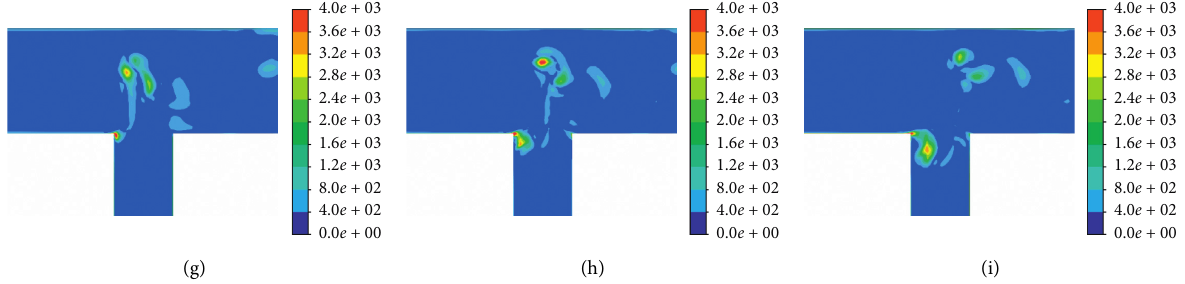
Figure 13: Vorticity ( t 3 � 1.7–1.72s unit: s − 1 ): (a) 0T/8, (b) 1T/8, (c) 2T/8, (d) 3T/8, (e) 4T/8, (f) 5T/8, (g) 6T/8, (h) 7T/8, and (i) 8T/8.